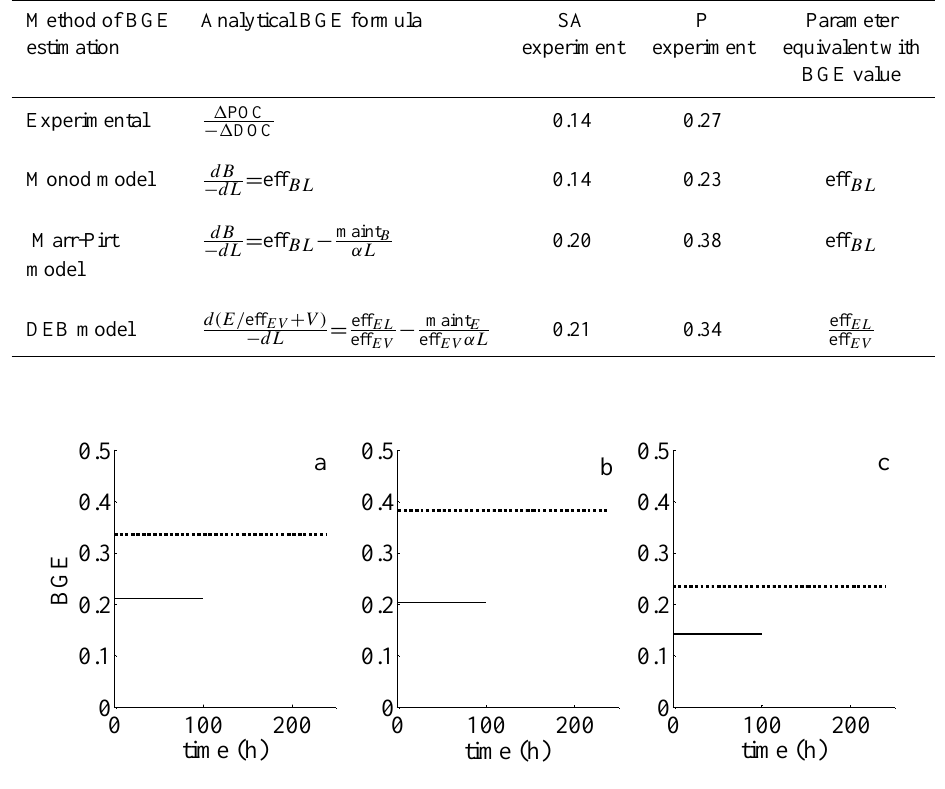
Fig. 5. Dynamics of BGE for the SA (solid line) and the P (dotted line) experiments estimated with (a) the DEB, (b) Marr-Pirt and (c) Monod models. BGE were estimated as the ratio between the variation of the bacterial biomass and the variation of DOC. Their formula are summarised in Table